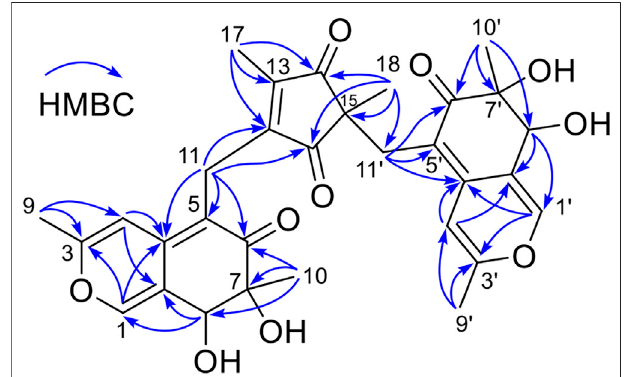
FIGURE 2 | The key HMBC correlations of compound 3